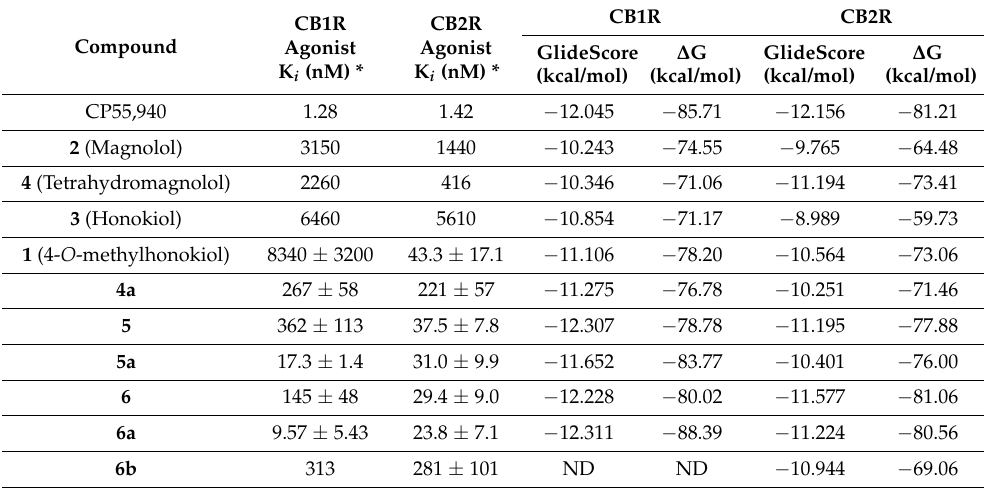
Table 3. Summary of docking scores and binding free energies ( ∆ G) of Magnolia compounds to the CB1 and CB2